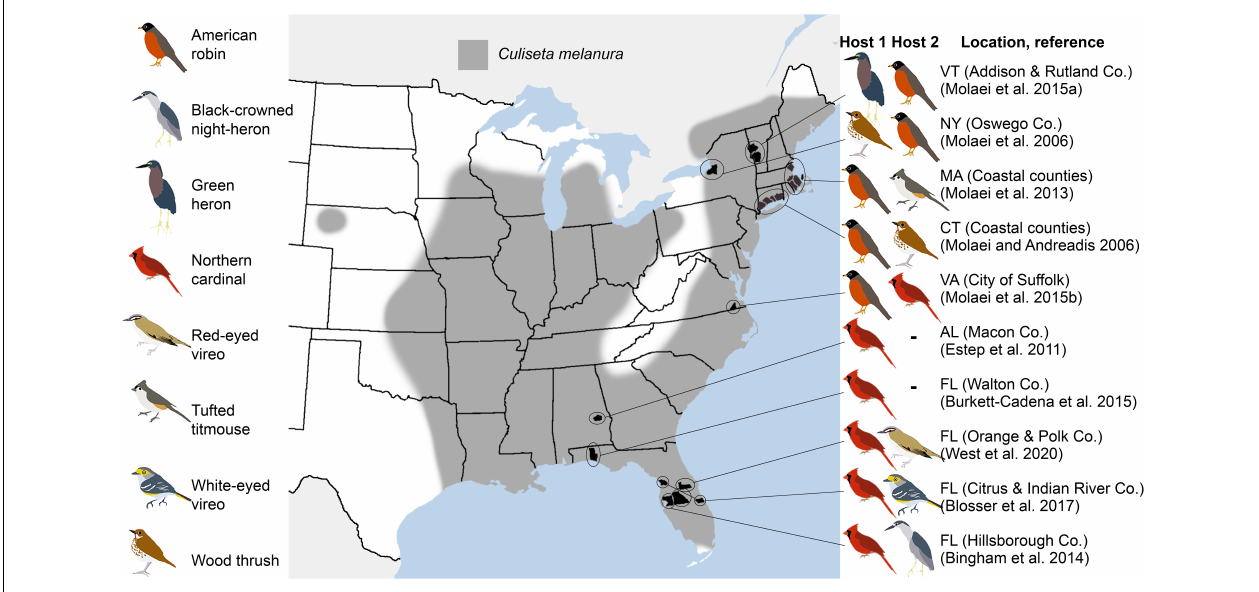
FIGURE 1 | Geographical patterns of avian host use by Cs. melanura . The first and second most commonly bitten avian hosts are presented for PCR-based studies of bloodmeal analysis of Cs. melanura in North America. Distribution of Cs. melanura after Darsie and Ward (2005). Dash represents several equally fed upon secondary avian